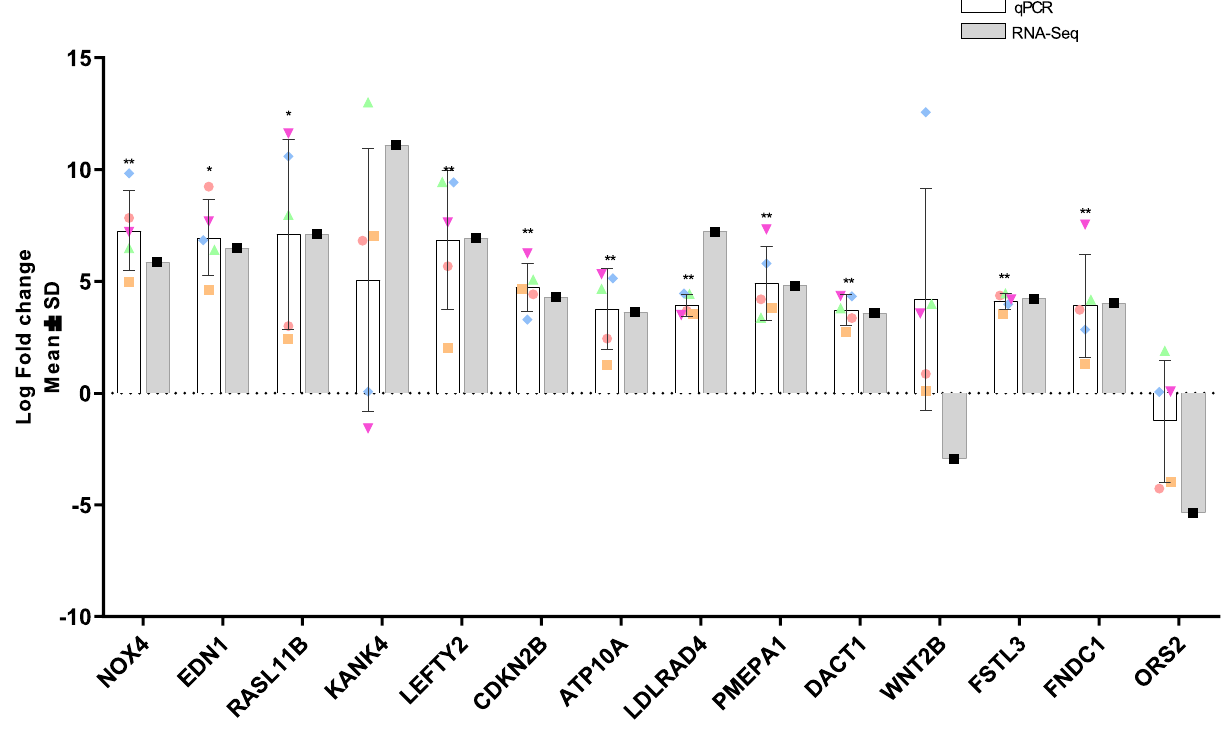
Figure 4. RT-qPCR confirmation and comparison of RNA-Seq results. A total of 5 control and TGFβ2 stimulated TM donor cells were used for the validation of gene expression patterns from the RNASeq analysis using RT-qPCR. Values were normalised to GAPDH and graphed as log fold change. Statistical significance was determined using a two-sample t test (*p <